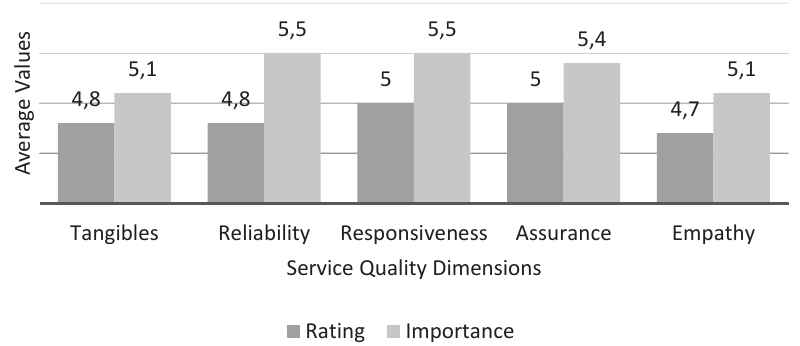
Figure 4. Comparing service quality importance ratings with actual ratings for each service quality